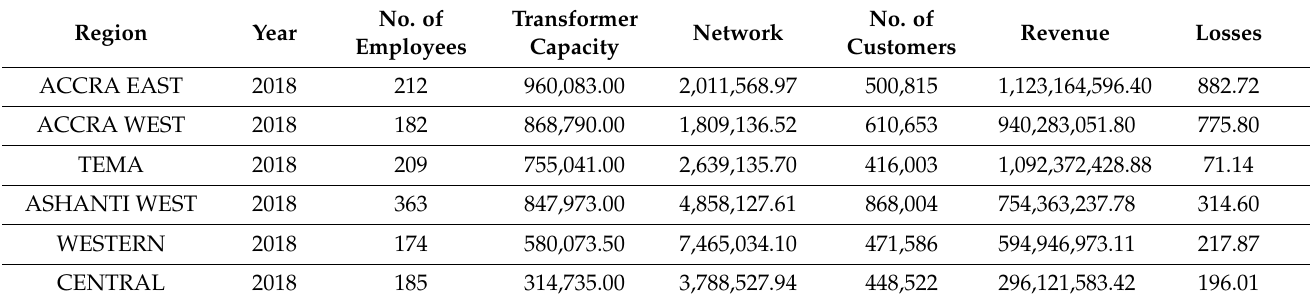
Table 1. Data used for